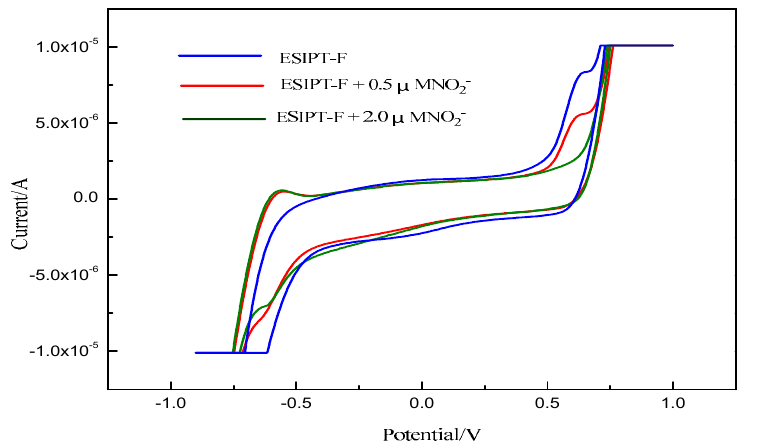
Figure 3. Cyclic voltammograms of 10 µ M ESIPT-F in DMF-HEPES solutions (3/1, 10 mM. HEPES, pH 7.2) and the same ESIPT-F in the presence of different concentrations of NO 2 − . Scan rate: 50 mV/s.